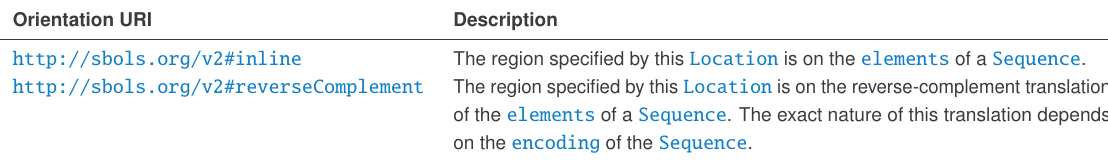
Table 8: REQUIRED URI s for the orientation